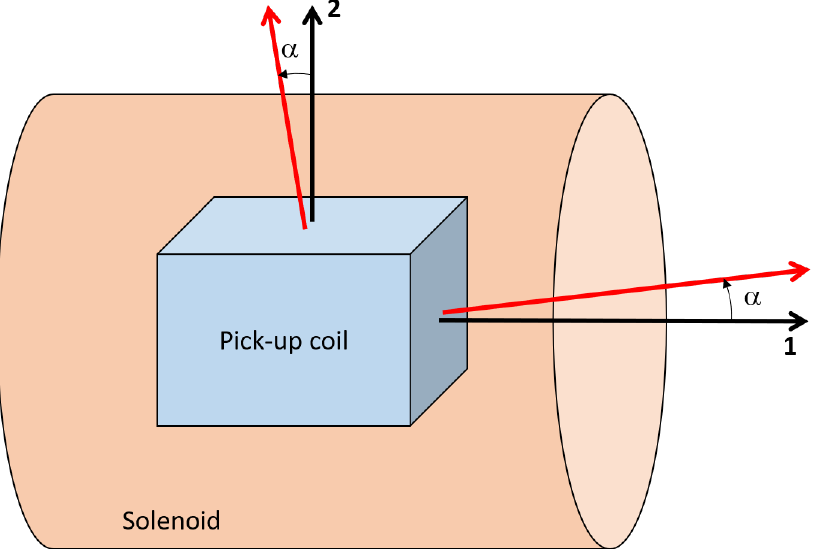
Figure 10. Graphic representation of the solenoid and the sensor with the related axes in black and red,